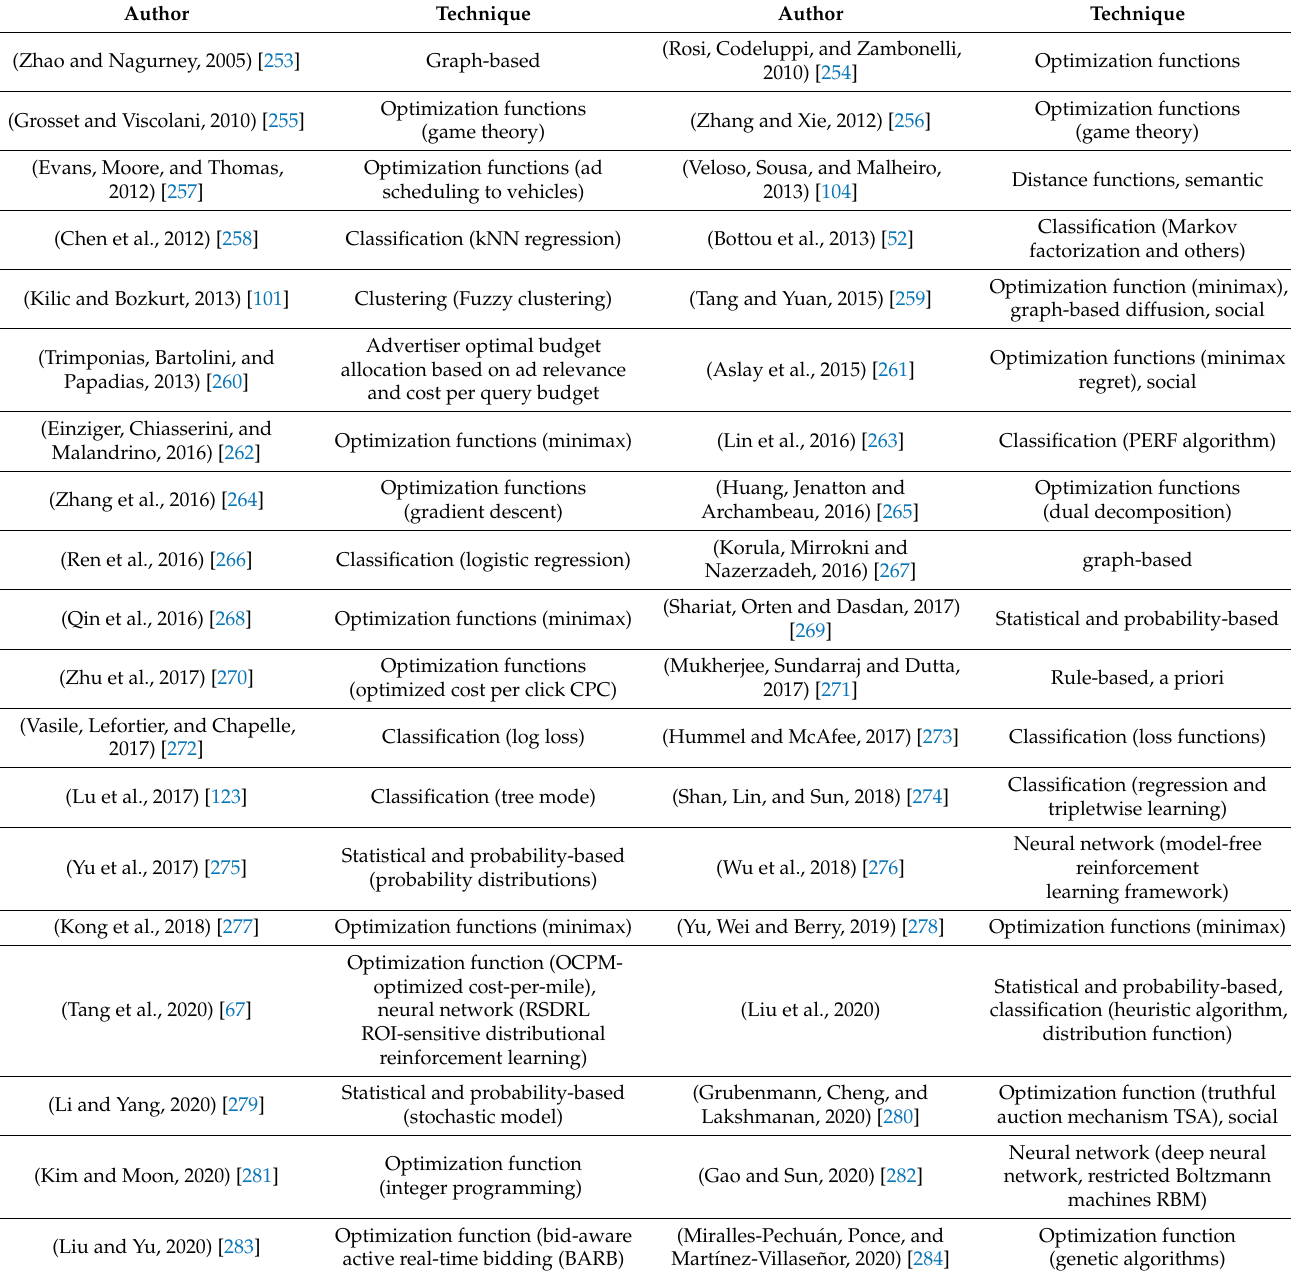
Table A4. Works that take advertisers bidding into account.